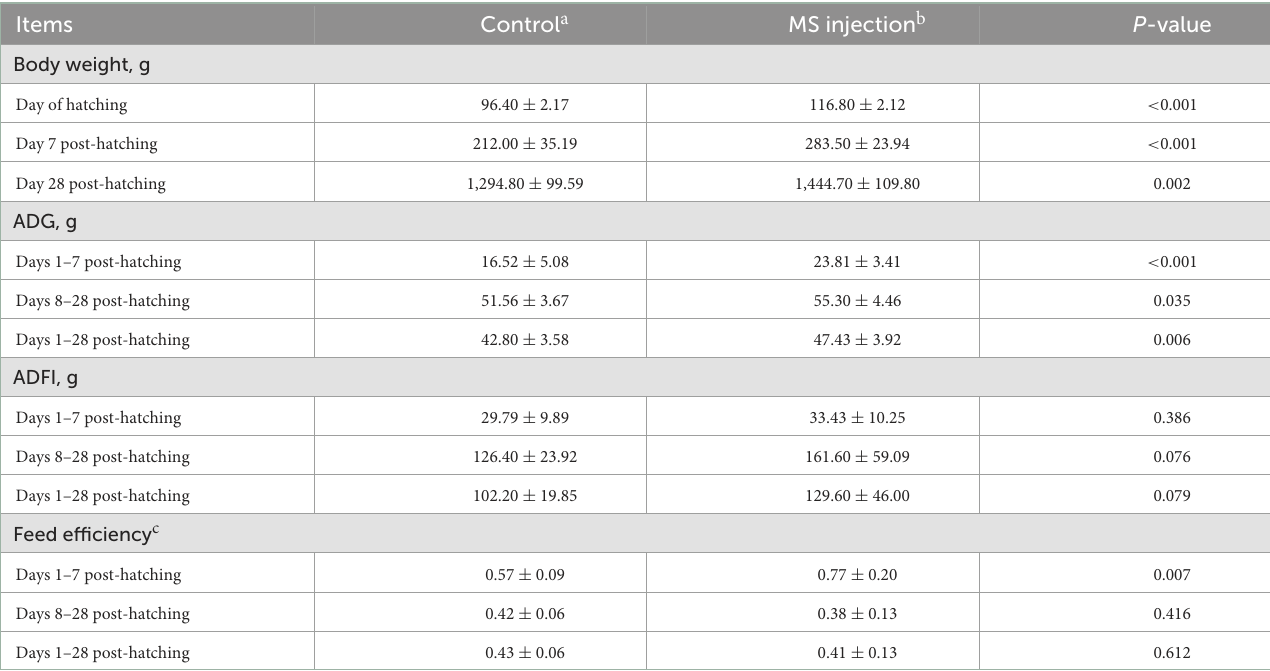
TABLE 3 Post-hatching growth performance of goslings as affected by the in ovo injection of maltase and sucrose.